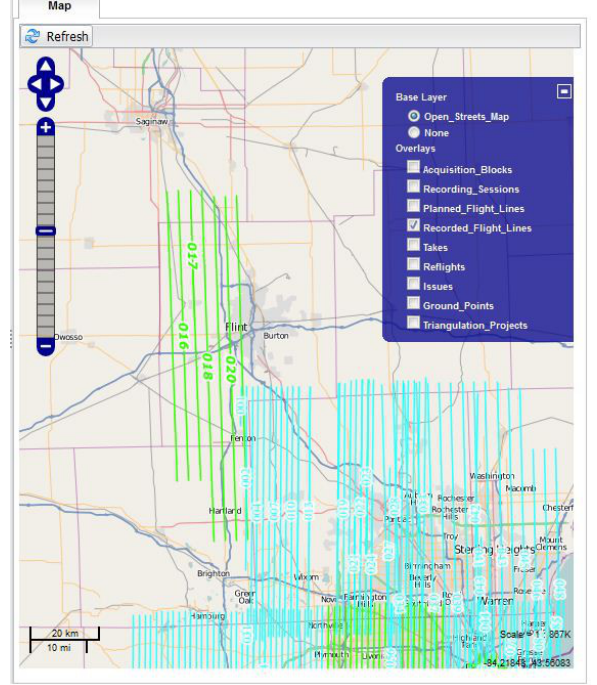
Figure 4: Planned flight lines